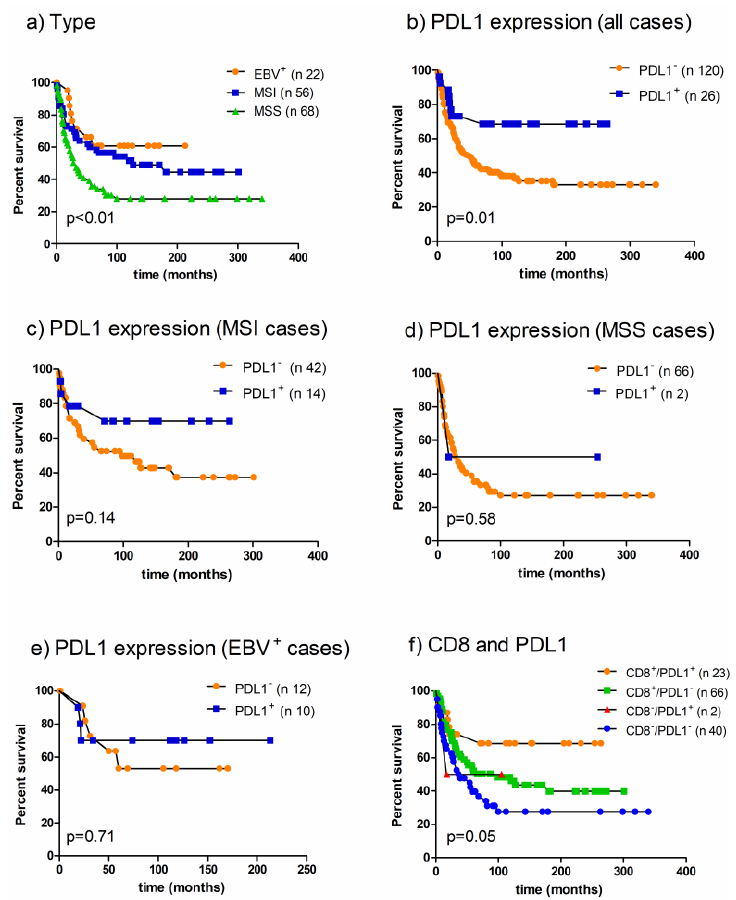
Figure 2. Failure time according to ( a ) EBV and MSI status (log-rank chi-square 9.34); ( b ) PD-L1